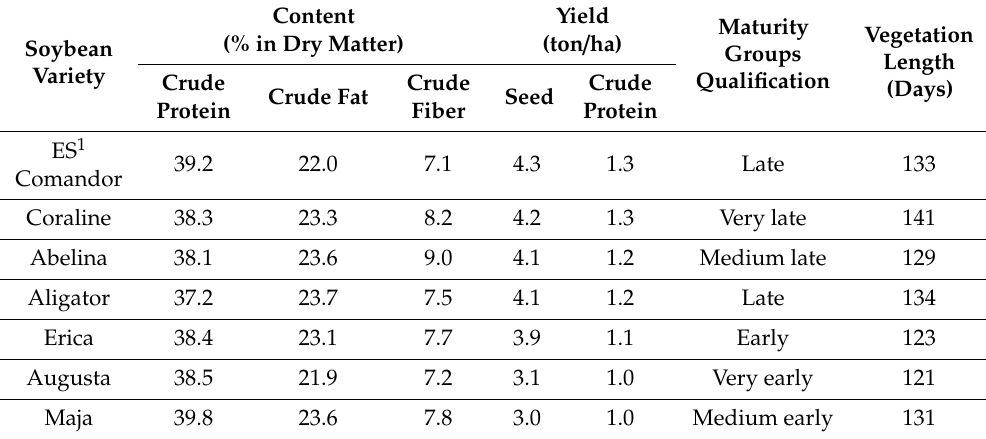
Table 1. Seeds chemical composition of non-genetically modified (n-GM) soybean varieties with the highest seed crude protein yield ( ≥ 1.0 ton / hectare), achieving harvest maturity in agro-climatic conditions of Poland in 2018